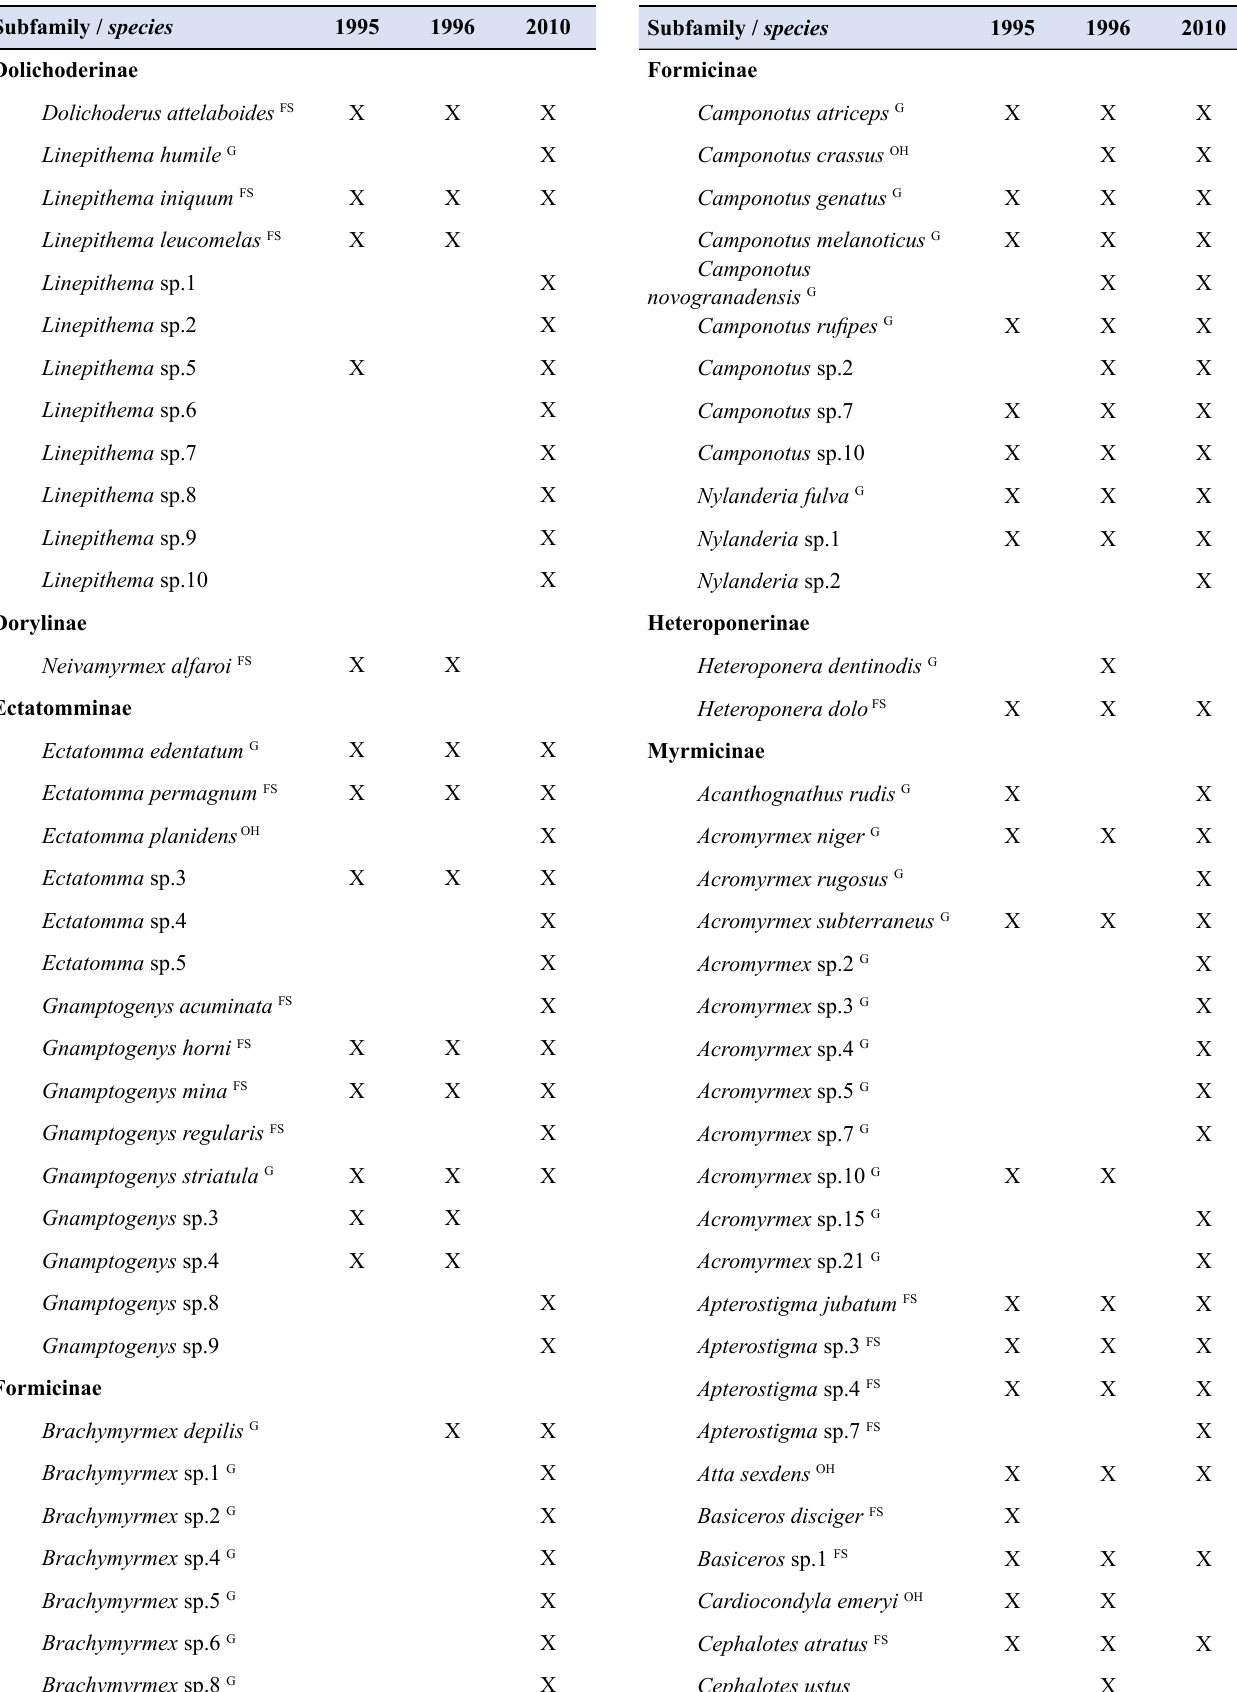
Table S3. Ant species sampled in the years of 1995, 1996 and 2010. The letter G represents the species classified as generalists, letters FS as forest specialist and letters OH those species classified as open-habitat specialist. Species that do not have any letter were